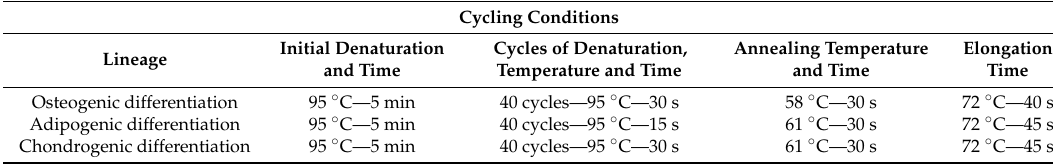
Table 4. Cycling conditions for osteogenic, adipogenic, and chondrogenic differentiation. (min, minutes and s,